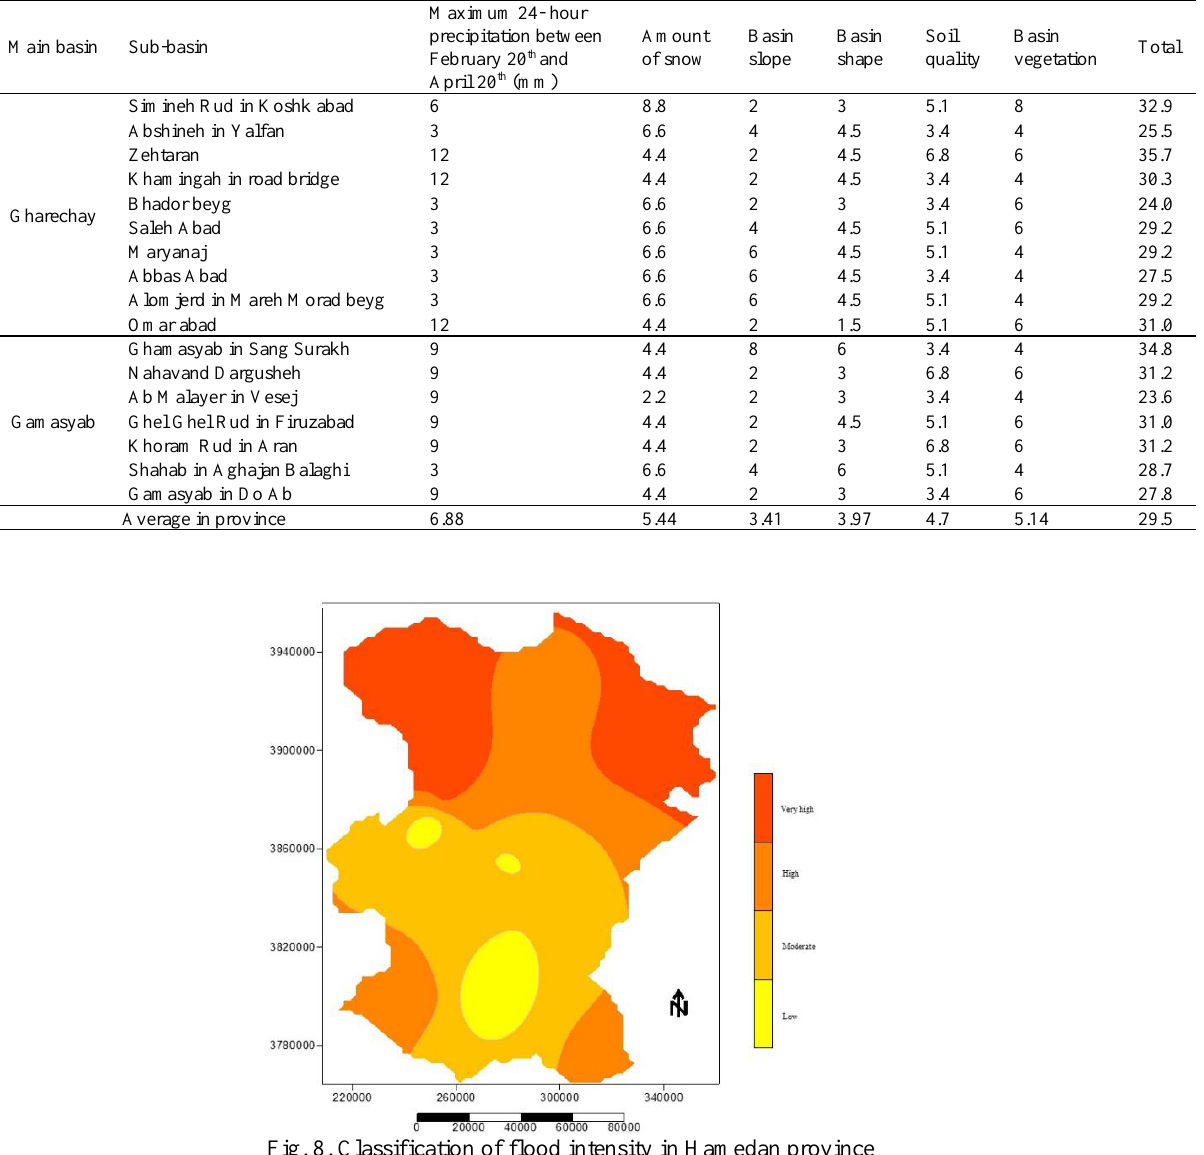
Amount Basin Basin Soil Basin Total of snow slope shape quality vegetation